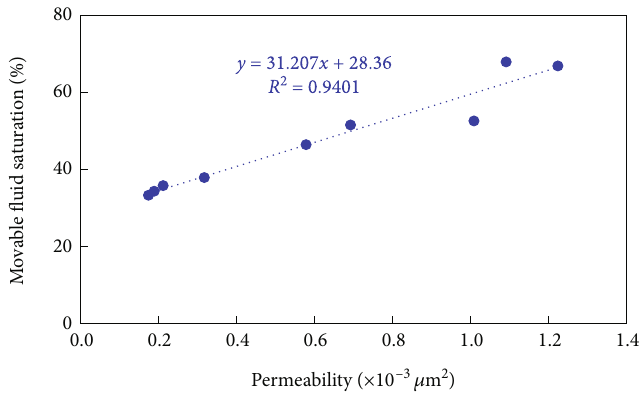
Figure 14: Relationship between permeability and movable fl uid